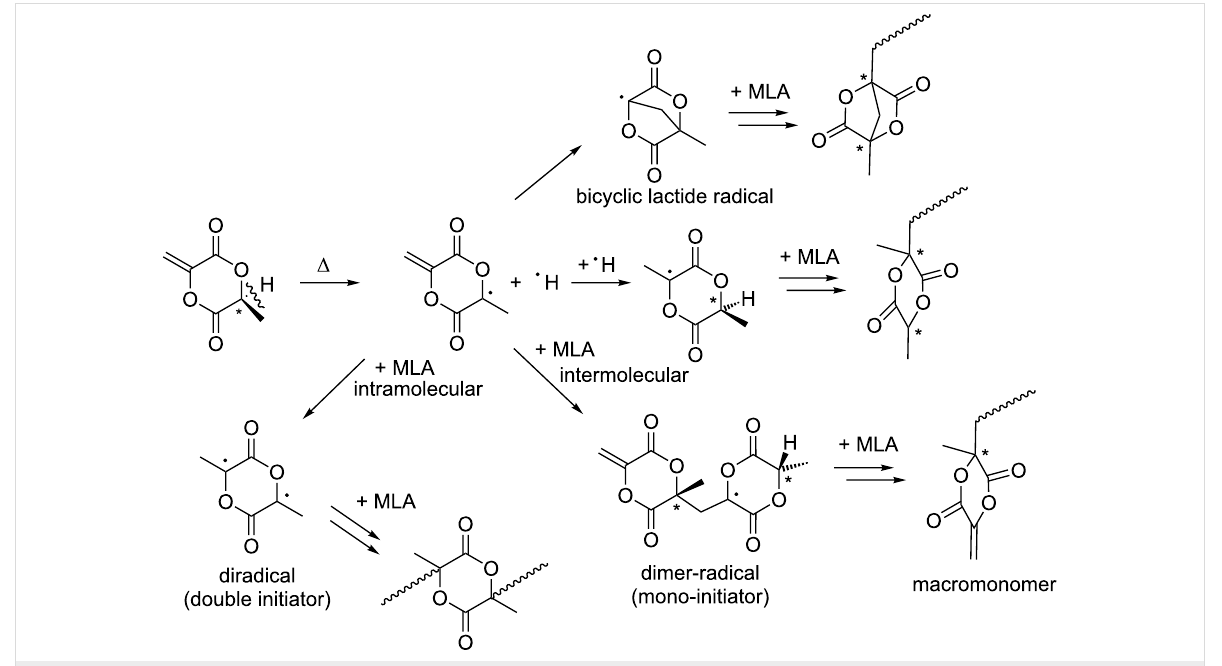
Scheme 2: Postulated mechanism of the self-initiation of MLA.